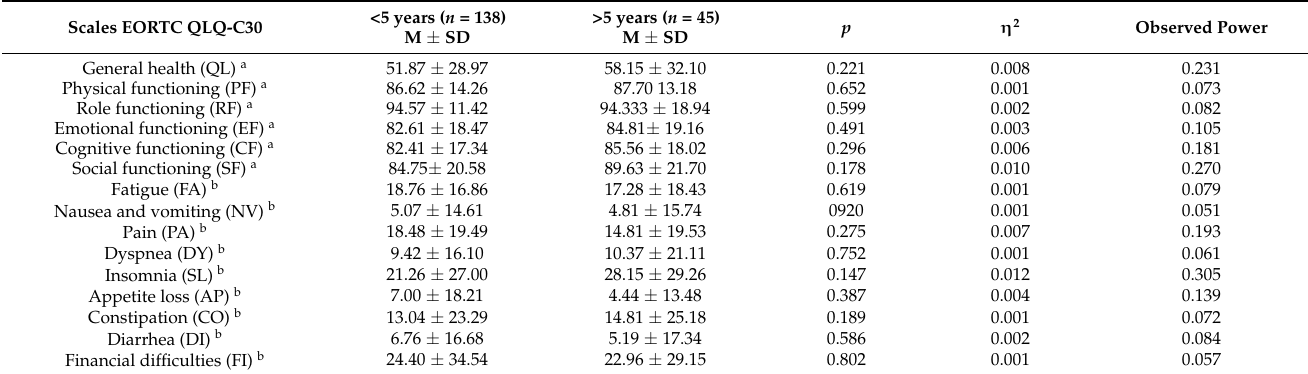
Table 6. Mean score of all items in EORTC QLQ-C30 of the study group (<5 years from diagnosis to QOL measurement vs. >5 years from diagnosis to QOL measurement).